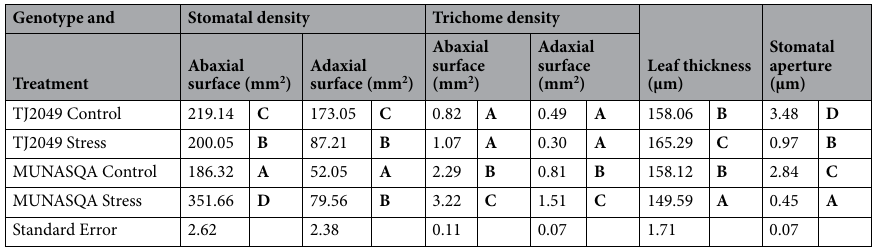
Table 3. Effect of mild water deficit on leaf morphology of MUNASQA and TJ2049. LT, TD_AB, TD_AD, ST_AB, SD_AD, and stomatal aperture were assessed in plants submitted to water deficit (Ψs = − 0.65 MPa) and well-watered treatments (Ψs = − 0.05 MPa) in R5 stage (except for stomatal aperture applied in V3). For LT, SD_AB, SD_AD, TD_AB and TD_AD, an independent experiment (n = 5 per genotype/treatment) was conducted, assessing parameters at 3, 10 and 21 days after stress (DAS) imposition. Here we showed the data corresponding to 21 DAS (n = 10 measured per sample). For stomatal aperture, three independent experiments (n = 40 stomatal measurements per genotype/treatment) were conducted, and the stomata evaluation was performed 72 hs after stress imposition. Average values followed by the same uppercase letter do not differ statistically according to Tukey’s HSD test at